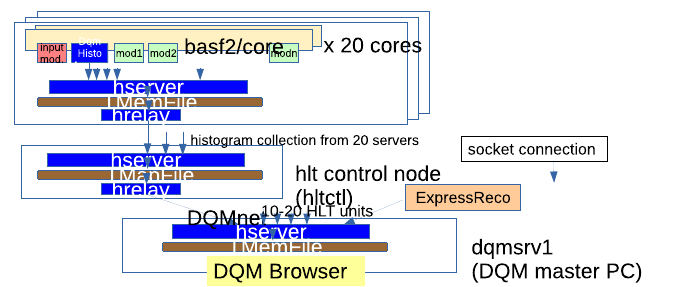
Figure 6. The real time histogram transport for data quality monitoring. The ROOT histograms accu- mulated in each event process on basf2 are sampled and transferred via the sockets, and added to the shared memory. By repeating the procedure in multiple steps, the histograms are finally collected on the DQM master node.